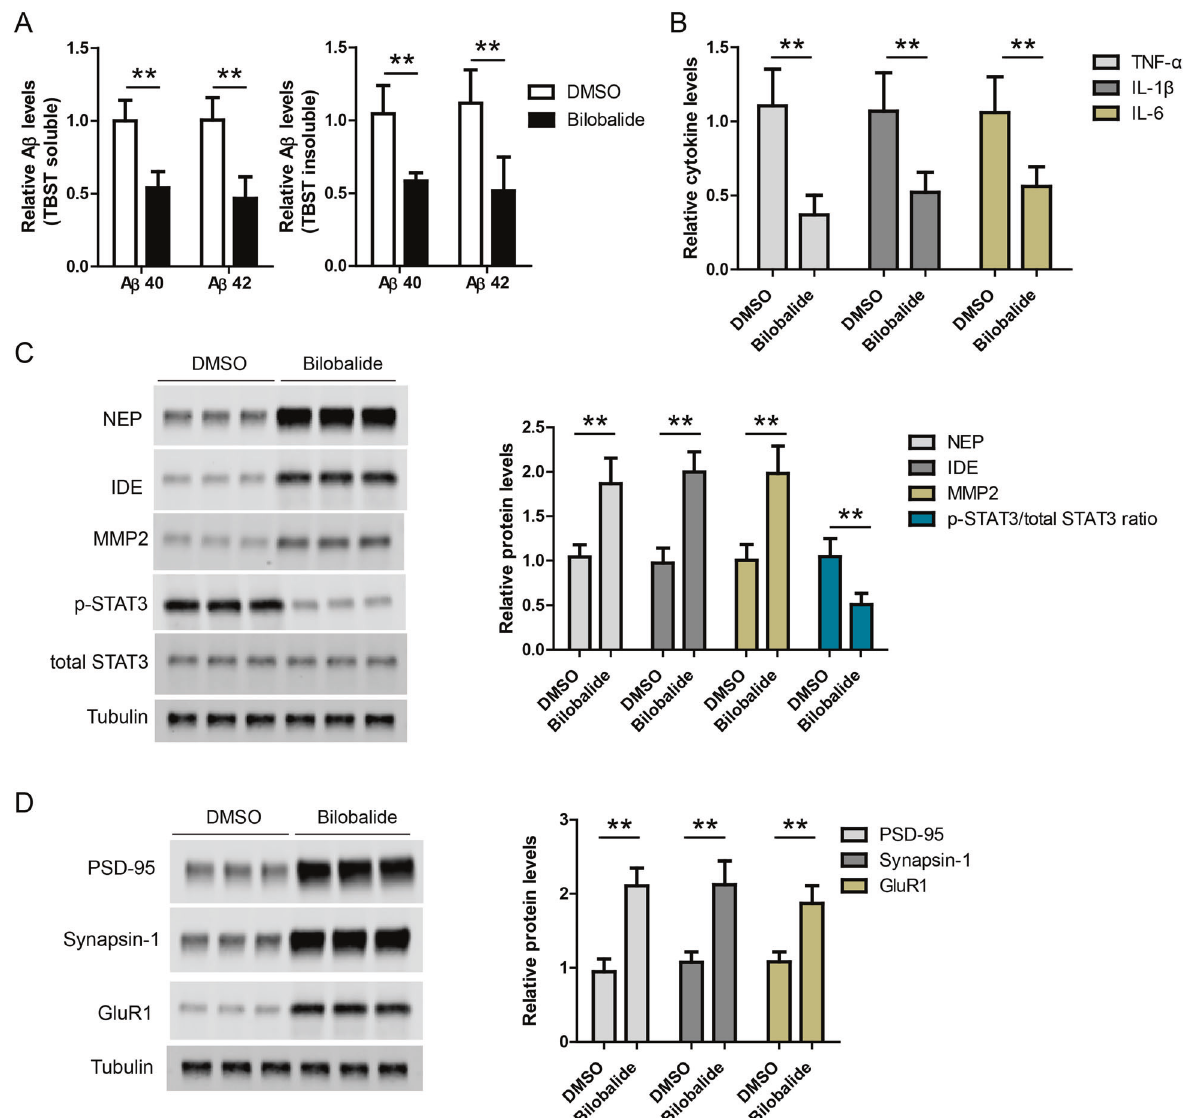
Fig. 6 Bilobalide reduces amyloid and in fl ammation in AD mouse brain. A ELISA results showing A β 42 and A β 40 levels in the brain lysates of APP/PS1 mice treated with DMSO ( n = 6) or Bilobalide ( n = 6). B ELISA results showing TNF- α , IL-1 β , and IL-6 levels in the brain lysates of APP/PS1 mice treated with DMSO ( n = 6) or Bilobalide ( n = 6). C Western blot and its quanti fi cation showing the protein levels of NEP, IDE, MMP2, and STAT3 in the brain lysates of APP/PS1 mice treated with DMSO ( n = 6) or Bilobalide ( n = 6). D Western blot and its quanti fi cation showing the protein levels of PSD-95, Synapsin-1, and GluR1 in the brain lysates of APP/PS1 mice treated with DMSO ( n = 6) or Bilobalide ( n = 6). ** P <